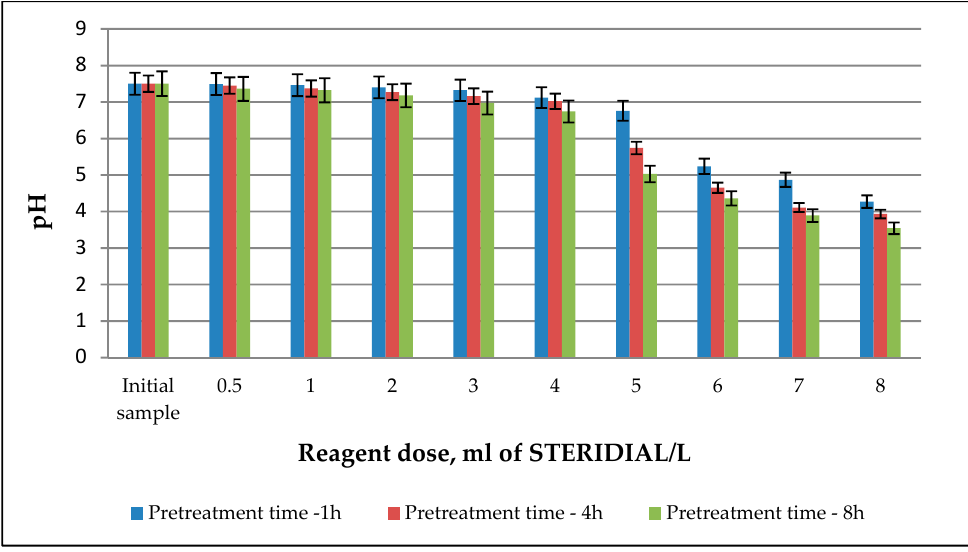
Figure 2. Changes in pH values determined in the sludge liquor subjected to 1, 4, and 8 h chemical disintegration of excess sludge vs. reagent dose.